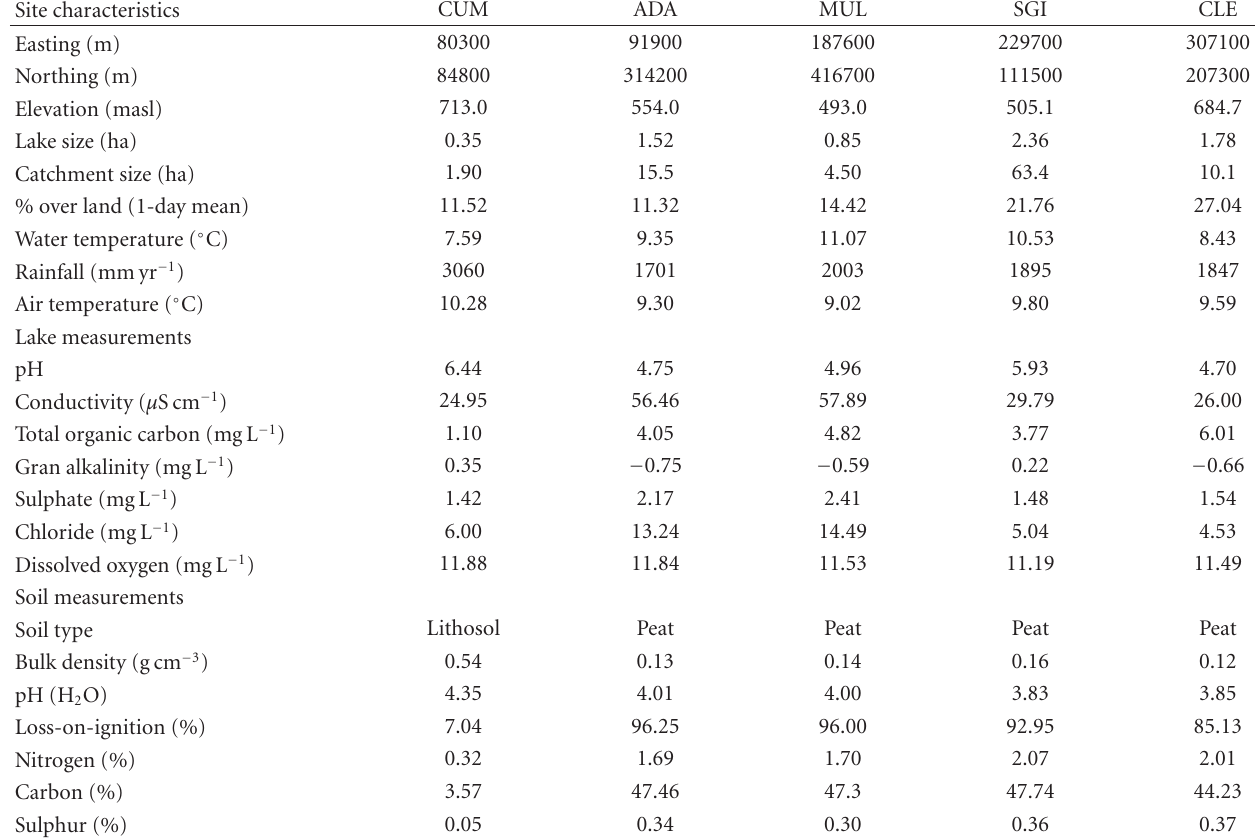
Table 1: Chemical, physical, and meteorological characteristics of study catchments ( n = 5): Lough Cummeenoughter (CUM), Lough Adanacleveen (ADA), Mullincrick Lough (MUL), Sgilloge Lough (SGI), and Cleevaun Lough (CLE). Lake chemical observations represent average concentrations during the period 2010-2011 ( n =